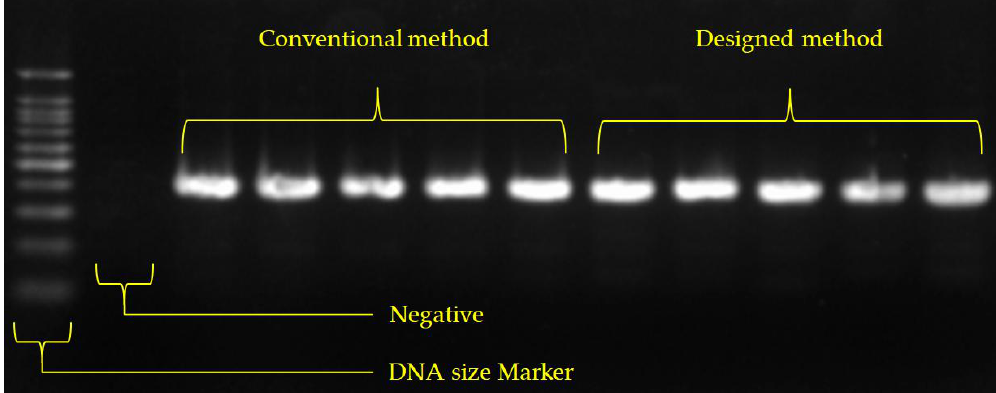
Figure 9. Photograph showing the electrophoresis comparison of the proposed LOD and existing spin column.